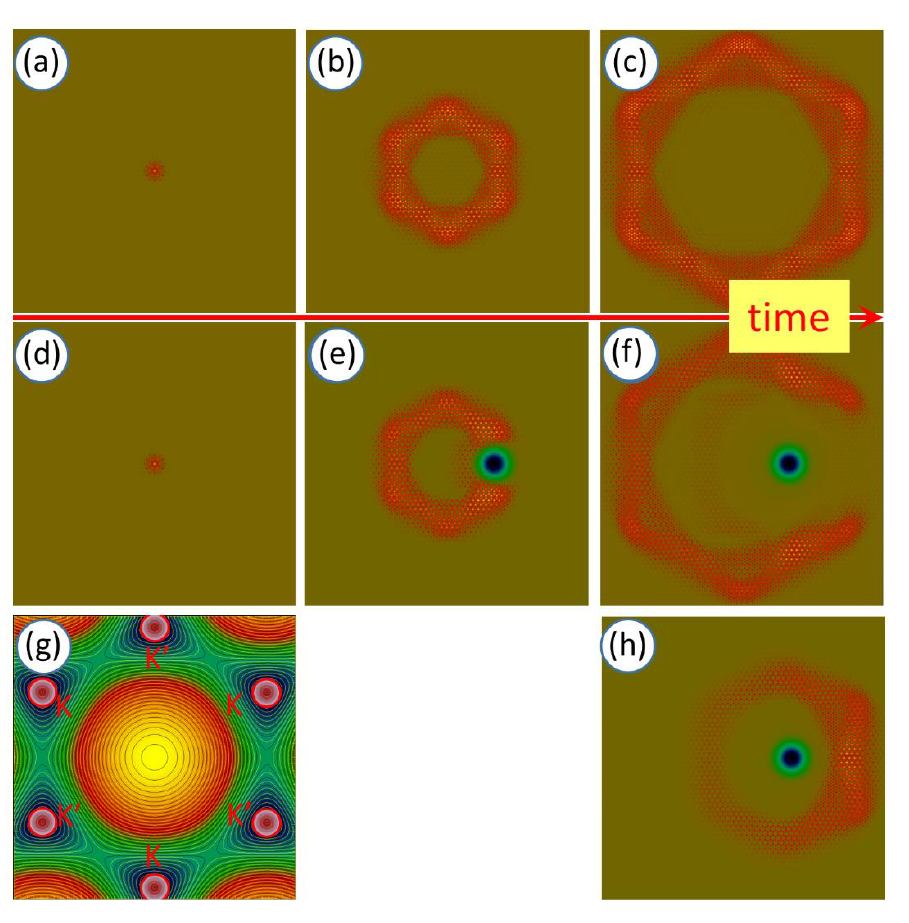
Figure 4. Time evolution of the probability density of a wave packet on the graphene surface with- and without defect. The band structure of the perfect crystal is incorporated into the kinetic energy operator, hence the potential is everywhere zero, except in the defect region. ( a – c ) Without defect. ( d – f ) With defect. The defect is shown by a blue spot. ( g ) Spectral distribution of the initial wave packet in the Brillouin zone (absolute value) is shown by red circles in the K and K ’ points, superimposed on the graphene band structure. The radius of the red circles is Δ𝑘/2 , the intensity of the red color is proportional to the spectral weight at each (𝑘⃗⃗ 𝑥 , 𝑘⃗⃗ 𝑦 ) points. ( h ) Scattering pattern, absolute value of the difference of the WPs shown on ( c , f ). The size of the calculation window is 23.04